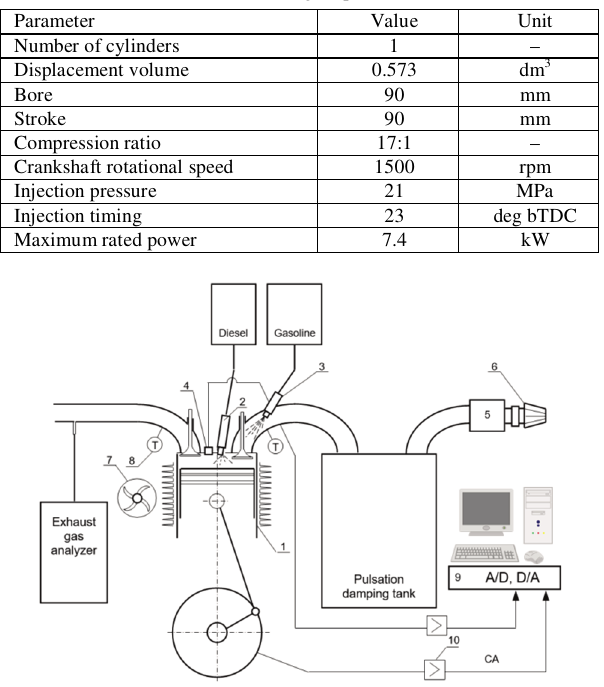
Fig. 1. Diagram of the experimental setup: 1 – engine, 2 – diesel fuel injector, 3 – ethanol fuel injector, 4 – in cylinder pressure sensor, 5 – intake air flowmeter, 6 – air filter, 7 – cooling fan, 8 – exhaust gases temperature sensor, 9 – PC with data acquisition system, 10 – crank angle